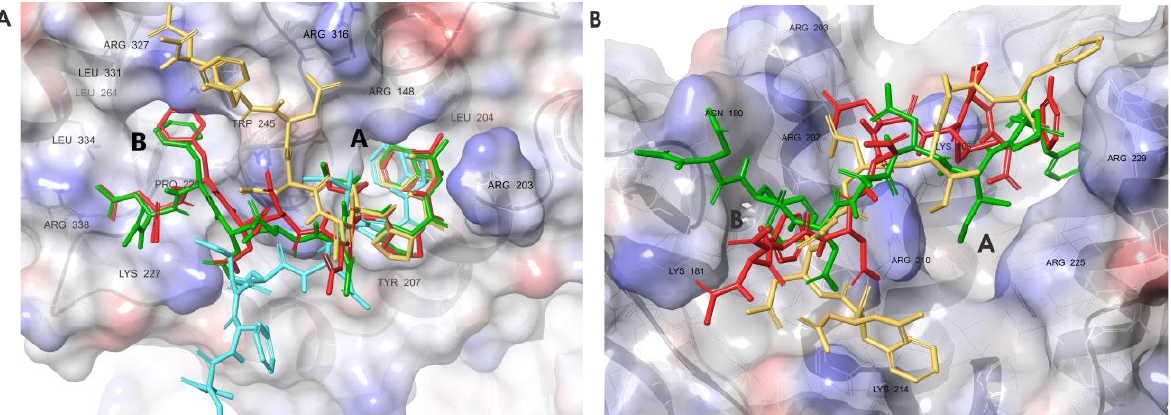
Figure 3. Representative structures of the MD simulations for the wtSSB-Ct–ExoI ( A ) and wtSSB-Ct–RecO ( B ) complexes, indicating the simultaneous binding of both proximal and distal segments at sites A and B. Proteins are shown in surface representation, wtSSB-Ct conformations appear as sticks. Structures were obtained with replica-exchange solute tempering (REST) molecular dynamics (cumulated time of 1.2 µs, temperature range of 308–500 K). The initial binding modes of wtSSB-Ct were obtained by docking wtSSB-Ct into ExoI and RecO structures (PDB ID 3C94 and 3Q8D) [10,11]. The modeling results reflected the non-uniform flexibility along the wtSSB-Ct chain